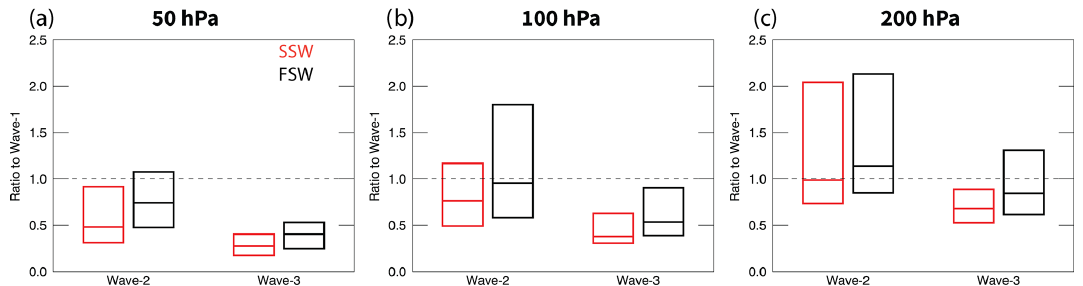
Figure 4. Ratio of wave-2 and wave-3 amplitudes relative to wave-1 amplitudes averaged for the 10d prior to either midwinter SSW events (red) or FSW events (black) for the 1958–2019 period in the NH at (a) 50hPa, (b) 100hPa, and (c) 200hPa. The top/bottom of the boxes show the quartile range and the solid horizontal line shows the median value for 35 midwinter SSW events and 62 FSW events. The dashed line shows where the ratio of amplitudes is equal to 1. The midwinter SSW dates are from Butler et al.